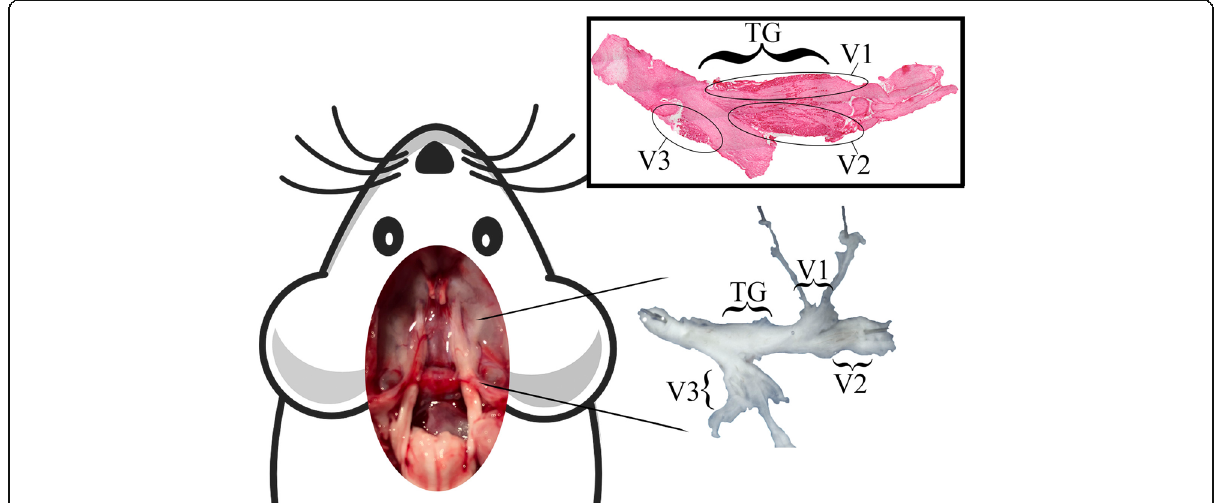
Fig. 2 Left : Superior perspective of a dissected male rat displaying both Meckel ’ s caves containing the trigeminal ganglion (TG). Right : TG and parts of its main branches. Insert : Hematoxylin-eosin staining of rat TG displaying neuron (darker areas) locations and their approximate branch